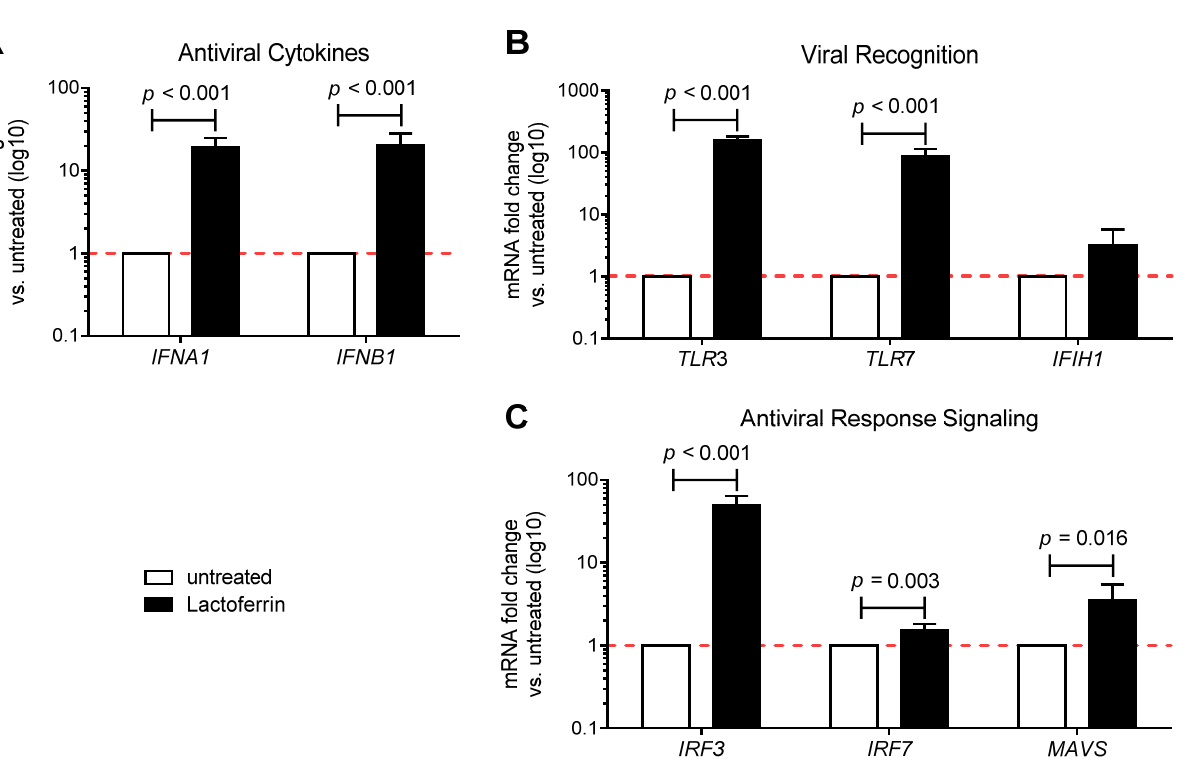
Figure 2. Lactoferrin enhances the antiviral immune response in vitro. Gene expression of ( A ) type I interferons, ( B ) innate immune receptors and ( C ) regulatory molecules of innate immune response was assessed by real-time qPCR in Caco-2 cells 24 h after a 3-h treatment with 100 µg/mL lactoferrin (n = 3–7). Data are shown as relative fold changes compared to untreated (arbitrarily set as 1) and presented as mean + SD.